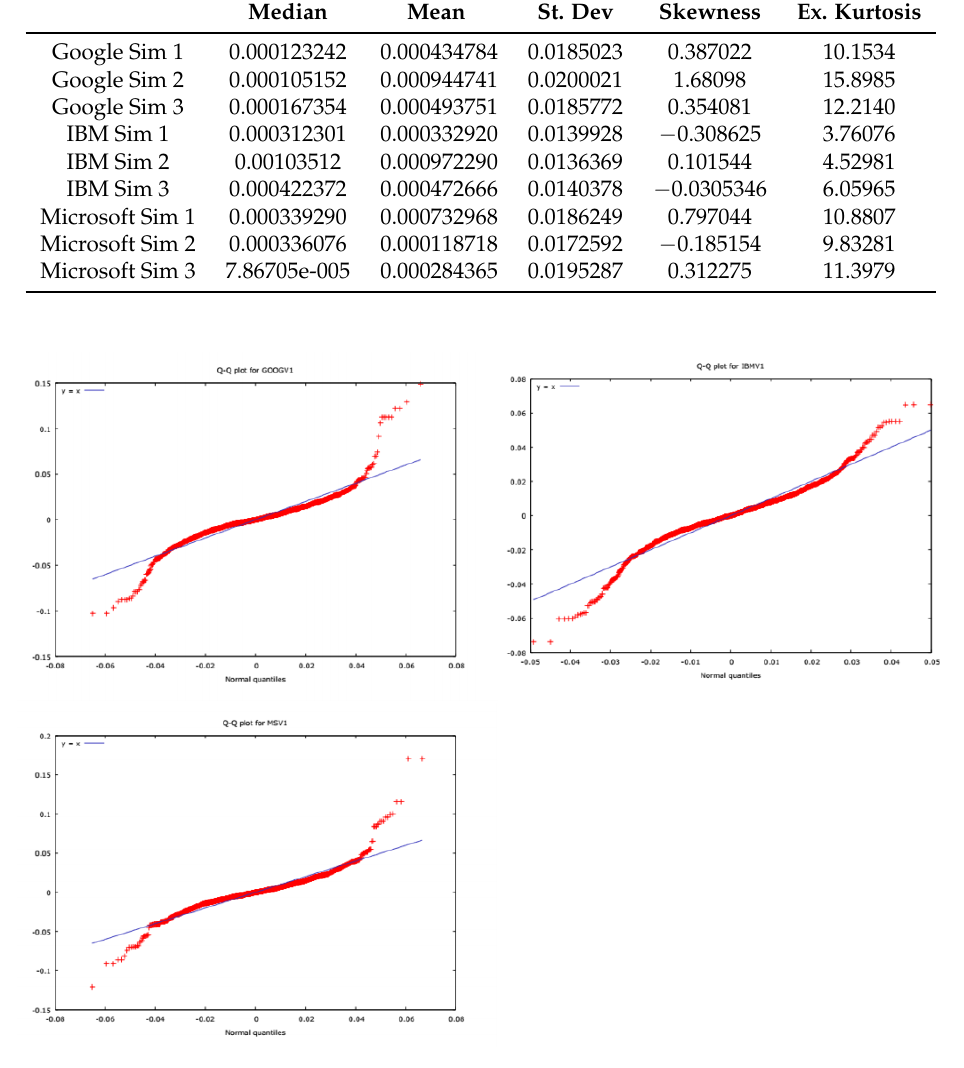
Figure 4. QQplots of Series 1 of the